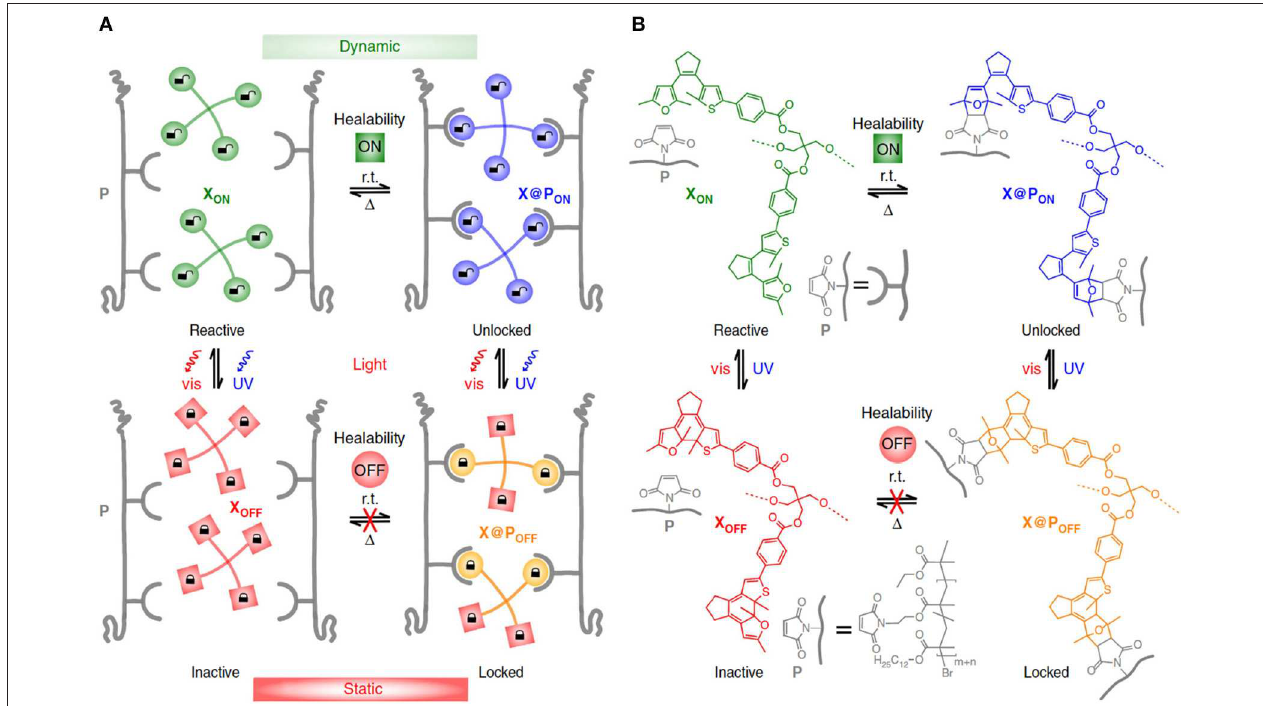
FIGURE 5 | Schematic representation of (A) photo-switchable, dynamically crosslinked polymer network and (B) the chemical structures of the crosslinkers, indicating the switchable reactivity for the reversible DA reaction and healability of the network (Fuhrmann et al., 2016). Reproduced with the permission of 2016 Springer Nature, United